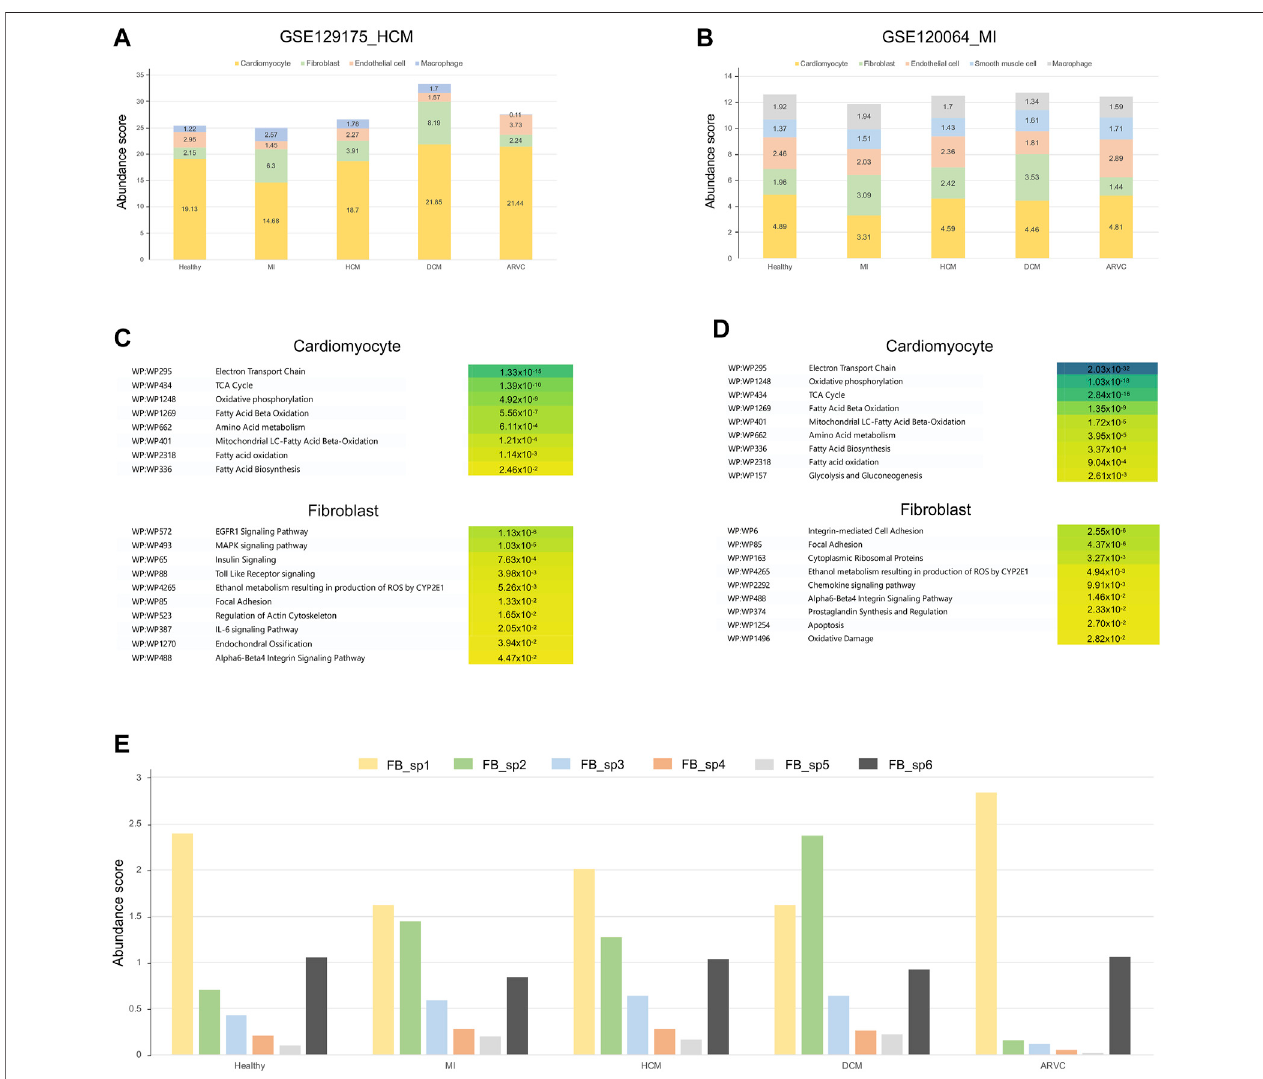
FIGURE 5 | Overview of transcriptome reconstruction results using disease-related scRNA-seq datasets from myocardial infarction (MI) and hypertrophic cardiomyopathy (HCM) heart samples as the alternative references. (A) Bar plot showing the cell type compositions estimated from the HCM scRNA-seq references (GSE129175). (B) Bar plot showing the cell type compositions estimated from the MI scRNA-seq references (GSE120064). (C) The top enriched pathways of differentially expressed genes (DEGs) in cardiomyocytes and fi broblasts using the HCM scRNA-seq references. The corrected p -values are shown on the colored boxes.Pathwaysactuallydescribingdiseasegenesetsareexcludedtoavoidconfusion. (D) ThetopenrichedpathwaysofDEGsincardiomyocytesand fi broblastsusing theMIscRNA-seqreferences.Thecorrected p -valuesareshownonthecoloredboxes.Pathwaysactuallydescribingdiseasegenesetsareexcludedtoavoidconfusion. (E) The abundance of fi broblast subpopulations (FB_sp1 to FB_sp6) estimated from the fi broblast subgroup-annotated MI-related scRNA-seq reference (GSE132144) across different cardiac disease conditions.